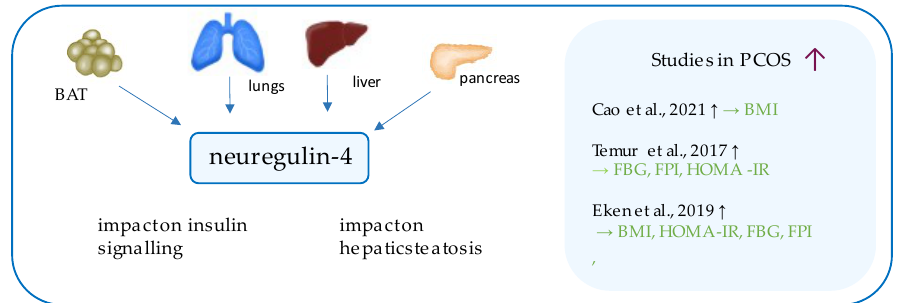
Figure 7. Role of neuregulin-4 in the pathogenesis of insulin resistance and PCOS. List of the studies assessing neuregulin-4 level in serum of the patients with PCOS. ↑ indicates that concentration level of neuregulin-4 was increased in PCOS individuals ( p < 0.05); → (green)—indicates positive correlation between serum neuregulin-4 and particular indicators; BMI—body mass index; FBG—fasting blood glucose, FPI—fasting plasma insulin, HOMA-IR—Homeostatic Model Assessment for Insulin Resistance.